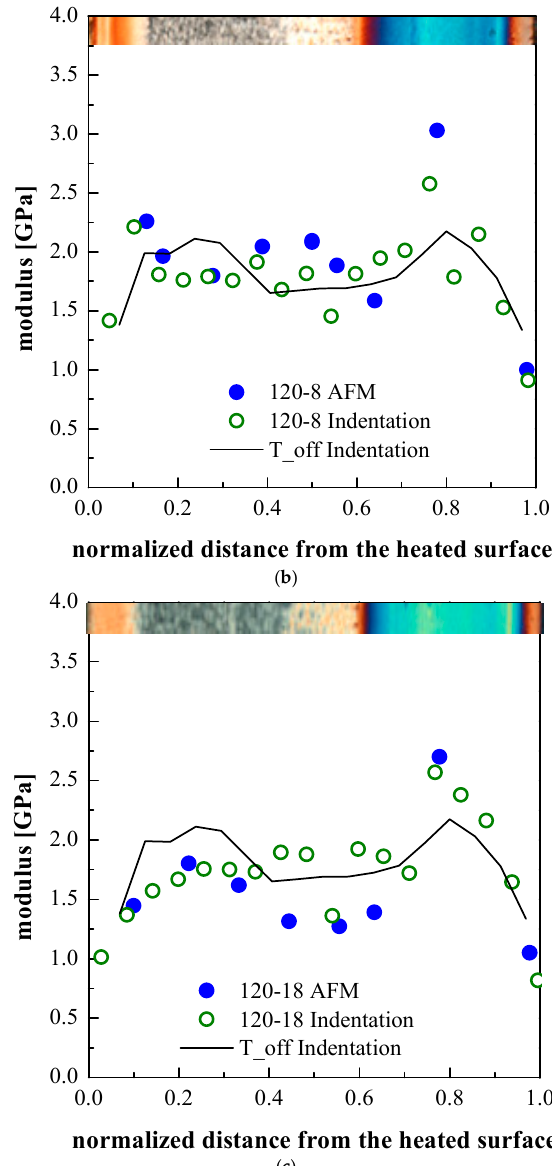
Figure 8. Distributions of elastic modulus along the sample thickness obtained by indentation and HarmoniX AFM tests for the samples ( a ) 120-05; ( b ) 120-8 and ( c ) 120-18.